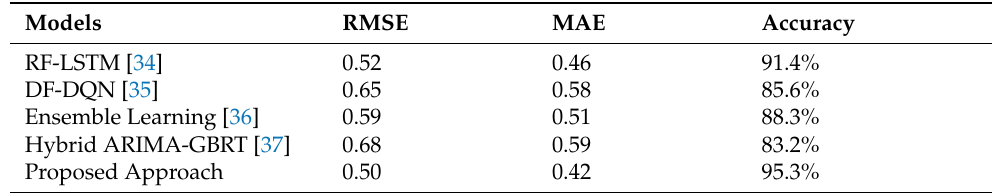
Table 8. Comparison of different prediction models from literature.